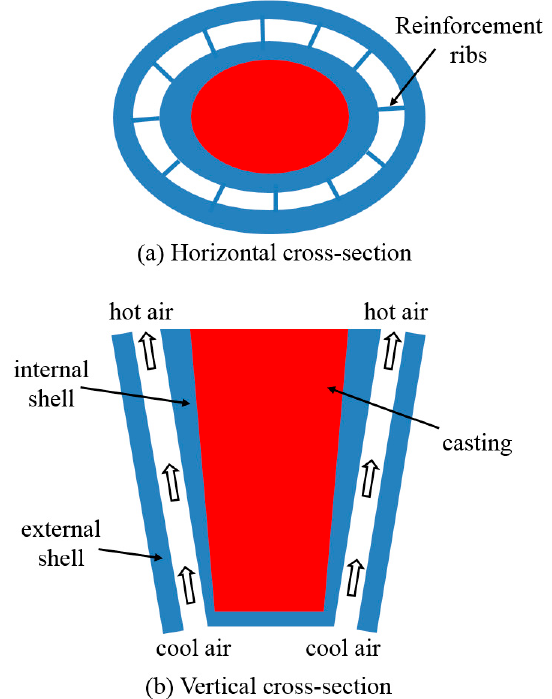
Figure 2. Schematic of a typical chimney structure of sand mold for casting. ( a ) Horizontal cross- section, ( b ) Vertical cross-section.